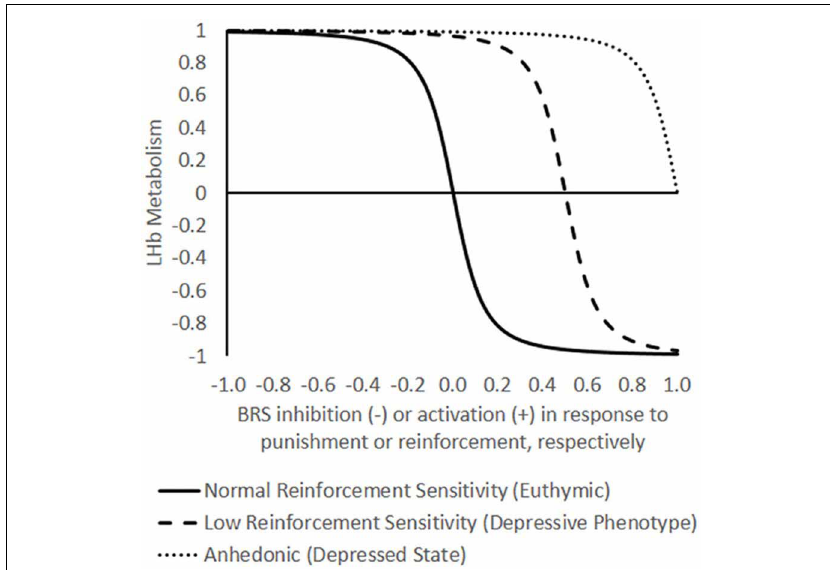
FIGURE 1 | Theoretical model of the functional opposition between lateral habenula (LHb) energy metabolism and the brain reward system (BRS). In the model, LHb metabolism (Y-axis) may oscillate between a neutral baseline (0) to maximal metabolism ( + 1) and minimal metabolism ( − 1). The X-axis represents BRS inhibition or activation in response to an emotional event that ranges from − 1, the maximum negative reward/punishment (withdrawal of pleasant stimulus or infliction of unpleasant stimulus) to + 1, the maximum reward/negative reinforcement (delivery of pleasant stimulus or withdrawal of unpleasant stimulus). Note that the choice of axes is arbitrary in terms of independent and dependent variables; in reality, the BRS and LHb are mutually interdependent. Differences in reinforcement sensitivity are represented by three separate curves (normal, low, and where A is the preexisting affective state, anhedonic) defined by the function − A + E √ ( A + E ) 2 + B − 1 E is an emotional event represented on the X-axis, and B is the degree of bistability (the steepness of the transition between high and low energetic states), held constant here at an arbitrary value of 50. The model captures the dramatic, bimodal shifts in LHb metabolism that have been empirically observed in response to manipulating the brain reward system (BRS) in “euthymic” animals with normal reward sensitivity ( A = 0). High energy states of the LHb (positive values on Y-axis) are presumed to inhibit the BRS, and low energy states (negative values on Y-axis) are presumed to disinhibit it. The model predicts that increasing levels of depressive predisposition × environmental stress (negative affect, A < 0) are reflected by increasing rightward shifts in the reinforcement-response curves such that increasing levels of reinforcement frequency or intensity are needed to bring the LHb into a low energy state until eventually a state of anhedonia is reached in which no amount of reinforcement is sufficient. The model predicts that differences in LHb function between depressives and healthy controls are more likely to be revealed under conditions of rewarding feedback (diverging curves on right side of graph) than under punitive feedback (converging curves on left side of